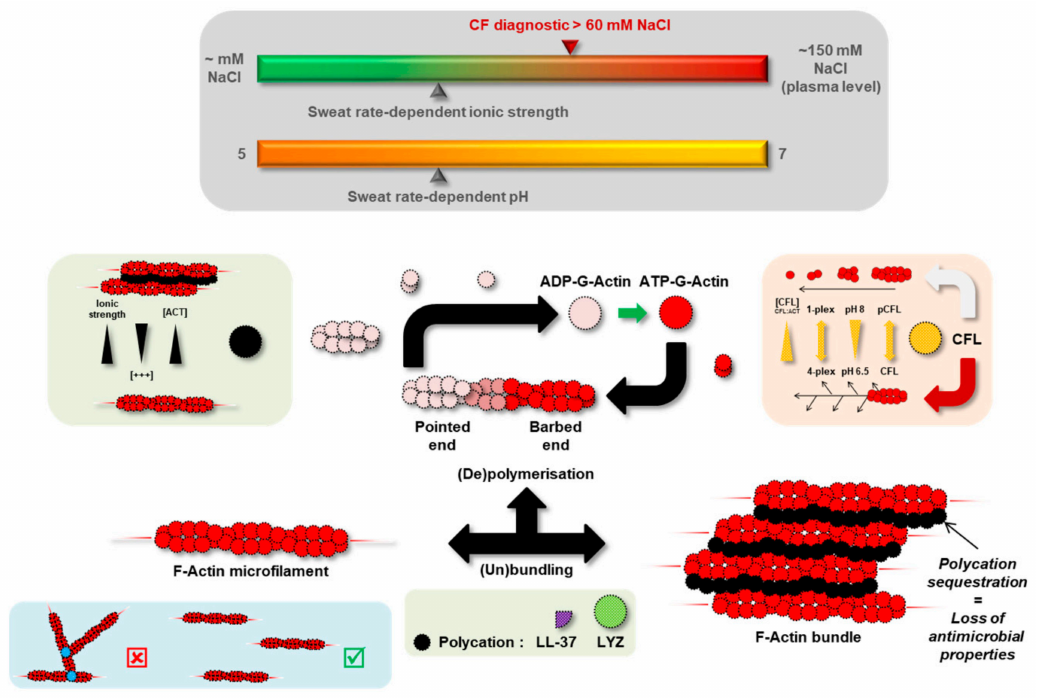
Figure 8. Hypothetical mechanism of F-actin microfilament reorganization in CF